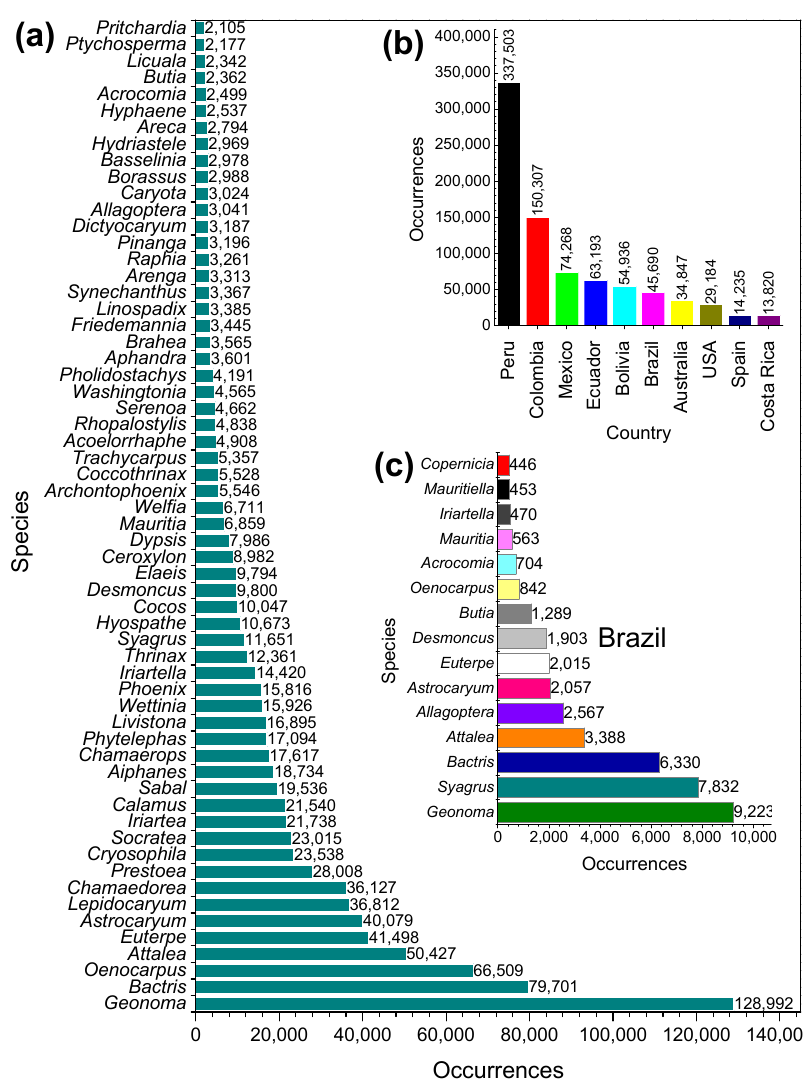
Figure 3. Occurrence of Arecaceae species around the globe. The 60 species with higher occurrence worldwide ( a ); the 10 countries with the highest rate of Arecaceae species ( b ), and the 15 main Arecaceae species found in Brazil ( c ). Adapted from Ref. [8].